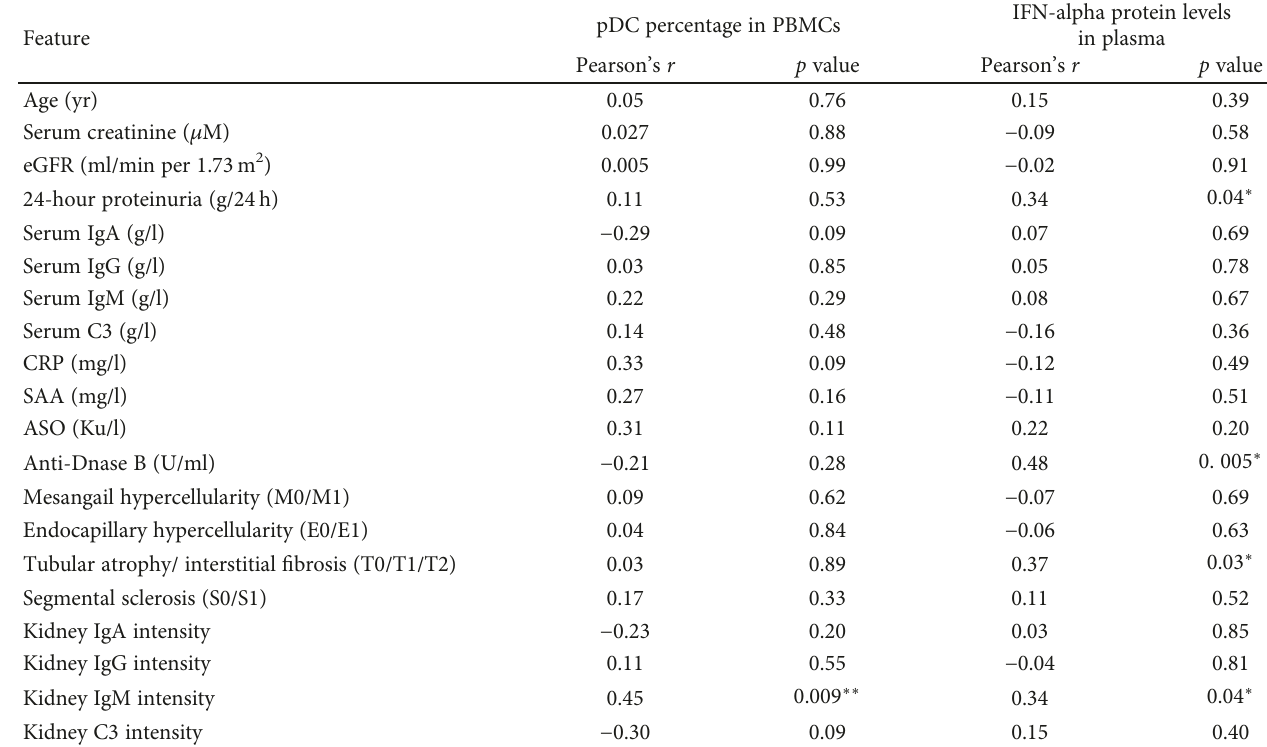
Table 2: Association of pDC and IFN-alpha with clinical parameters and renal histopathology in IgAN patients.